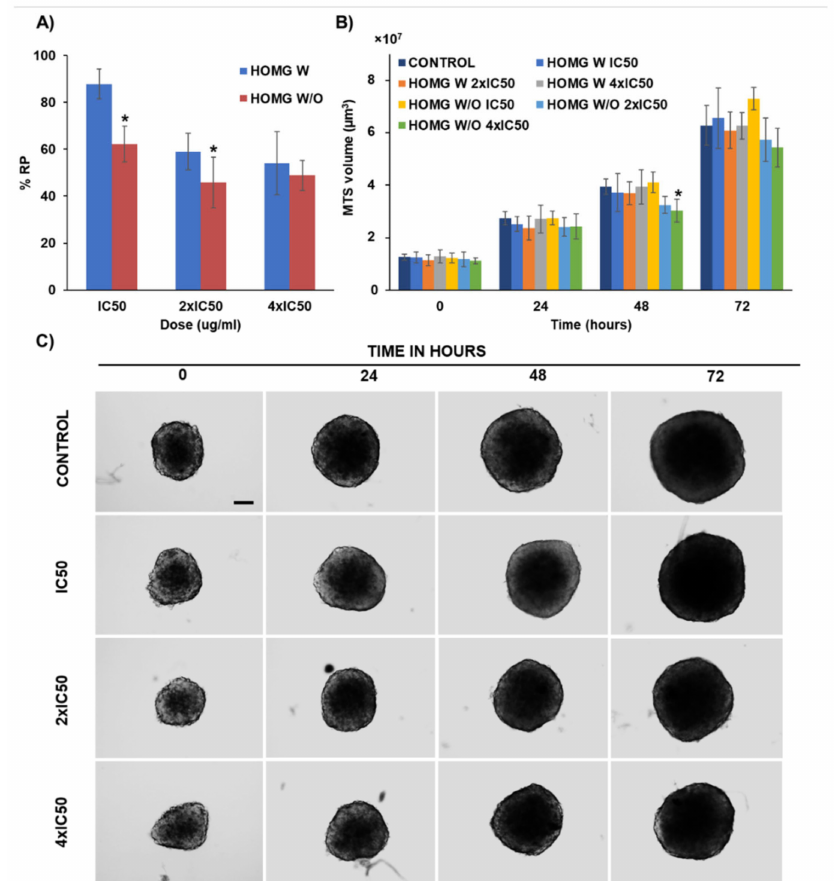
Figure 8. Multicellular tumor spheroids (MTS) from MC38 treated with the crude homogenates (HOMG). ( A ) Proliferation assay with CCK8 on MTS treated for 72 h with HOMG with (W) and without (W/O) symbiont at different doses (IC 50 , 2 × IC 50 and 4 × IC 50 ). ( B ) MTS volume measured at different times of exposure from the beginning of treatment (0, 24, 48 and 72 h). Data are represented as the mean ± standard deviation of octuplicate cultures. ( C ) Light microscopy images of the MTS treated with the crude homogenate without symbiont (HOMG W/O). The images were taken at 10 × magnification (scale bar = 100 µ m). The symbol * indicates significant differences between crude homogenates with (W) and without (W/O)